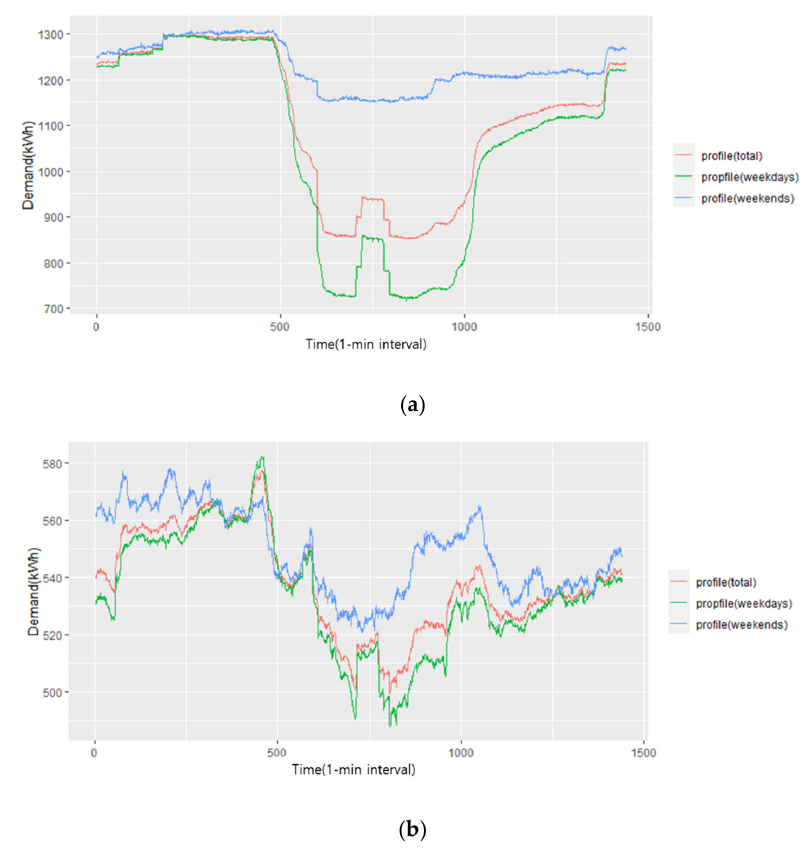
Figure 5. Electricity demand profile for ( a ) Cement plant #1, and ( b ) Cement plant #2.